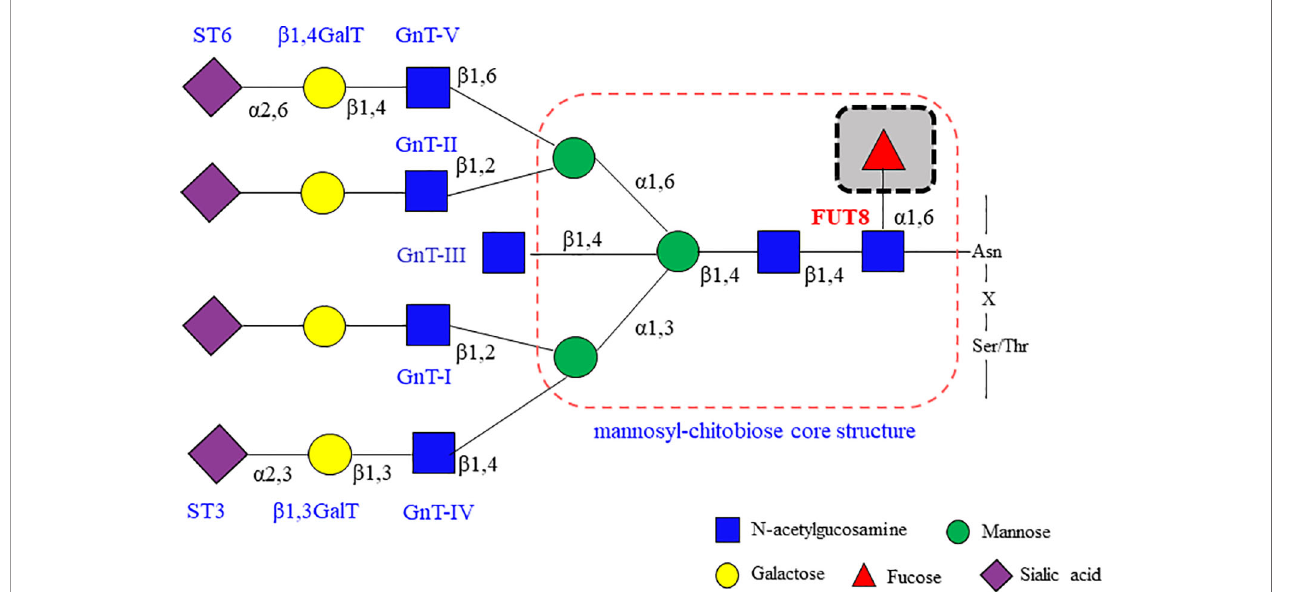
FIGURE 1 | Glycosyltransferases involving in the biosynthesis of branching N-glycans. a 2,6 sialyltransferases (ST6) and/or a 2,3 sialyltransferases (ST3) that act on galactose, b 1,4 galactosyltransferases ( b 1,4GalT) and/or b 1,3 galactosyltransferases ( b 1,3GalT) that act on N-acetylglucosamine (GlcNAc), and the family of N-acetylglucosamine transferases (GnT-I, GnT-II, GnT-III, GnT-IV, GnT-V and so on) that participate in GlcNAc synthesis. Fucosyltransferases (FUT3, FUT4, FUT5, FUT6, FUT7, FUT8, FUT9) can attach fucose in either a 1,3/ a 1,4 or a 1,6 linkage. These enzymes act sequentially, so that the product of one enzyme yields a preferred acceptor substrate for the subsequent action of another. Different proteins may have different subsets of N-glycans, which is referred to as microheterogeneity. All N-glycans share a common core sugar sequence, Man a 1 – 6(Man a 1 – 3) Man b 1 – 4GlcNAc b 1 – 4GlcNAc b